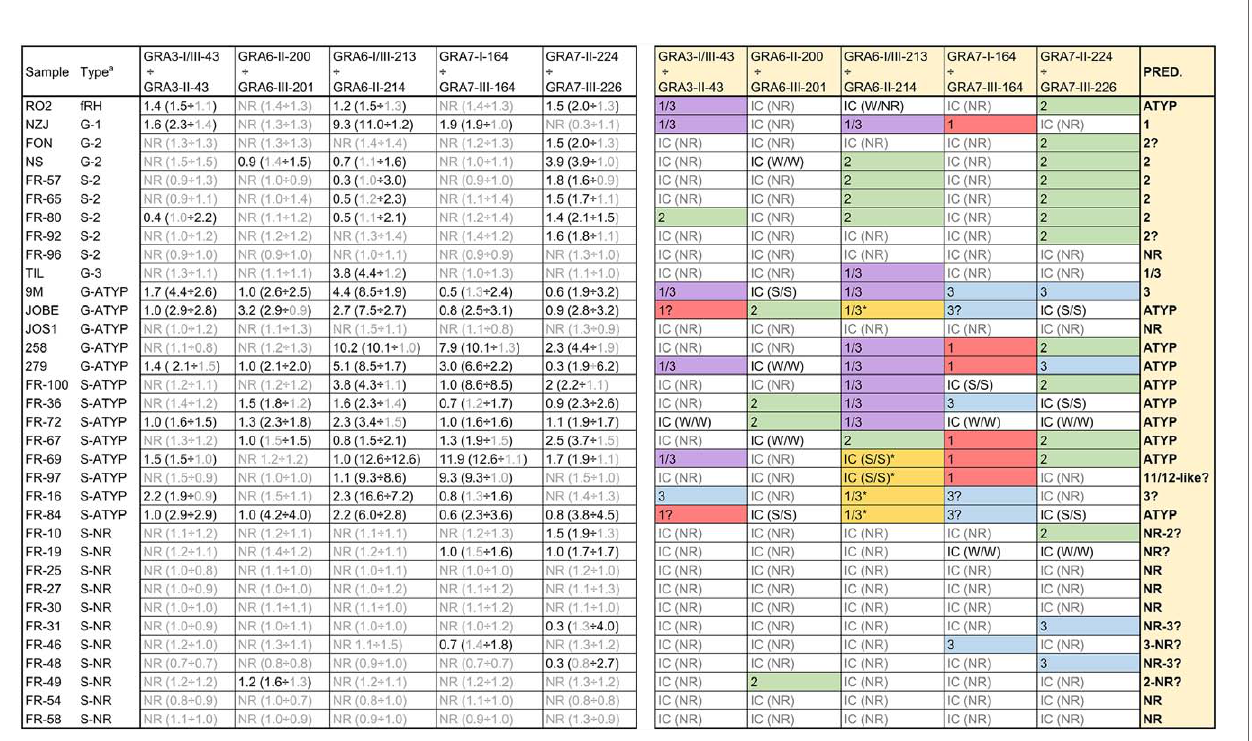
FIGURE 4 | Strain type prediction using human sera reactivity against a panel of Toxoplasma polymorphic peptides. On the left, ratios were calculated by dividing individual values from each peptide (in parenthesis). Readers are referred to Supplemental File 4 for further details on individual values. a G and S indicate the type of analysis (genotyping and serotyping, respectively) used to detect the strain type. ATYP: Atypical, non-archetypal (non-type 1, 2 or 3). NR: non-reactive. On the right, a prediction was made based on the ratio for each speci fi c peptide couple and the strain causing the infection inferred considering all individual predictions. IC stands for inconclusive. For IC samples, the strength of the reactivity against each peptide is shown in parenthesis as NR (non-reactive), W/W (weak/weak) or S/S (strong/strong). * denotes an unusual strong reactivity to both peptides in the GRA6-I/III-213 vs. GRA6-II-214